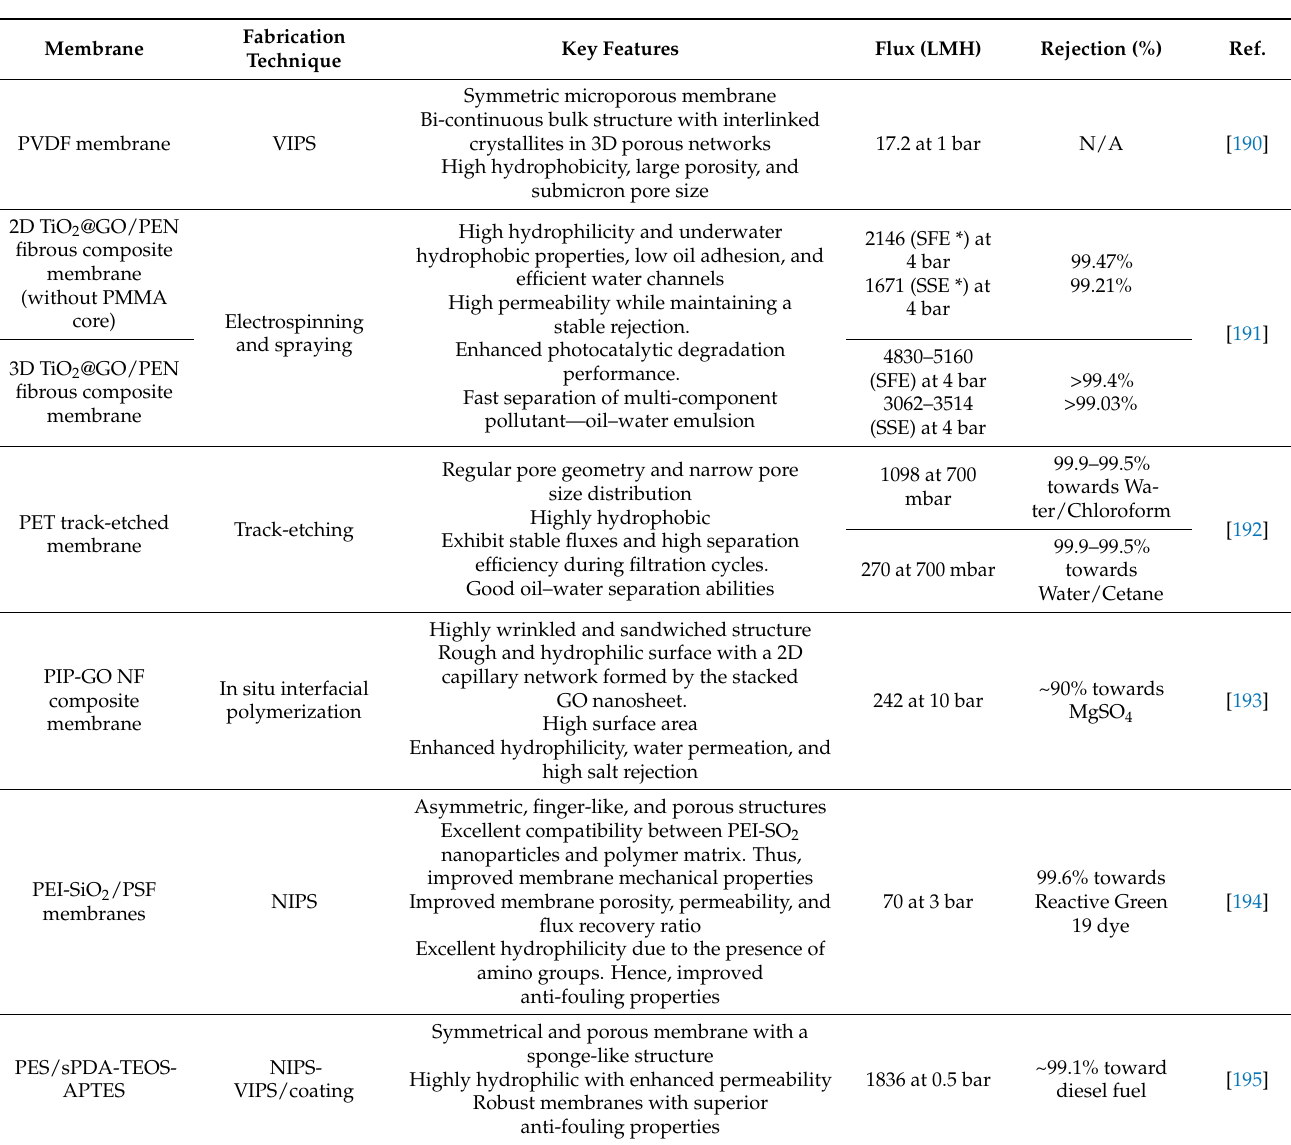
Table 8. Key features and performance of recent membranes prepared using different fabrication techniques for water treatment